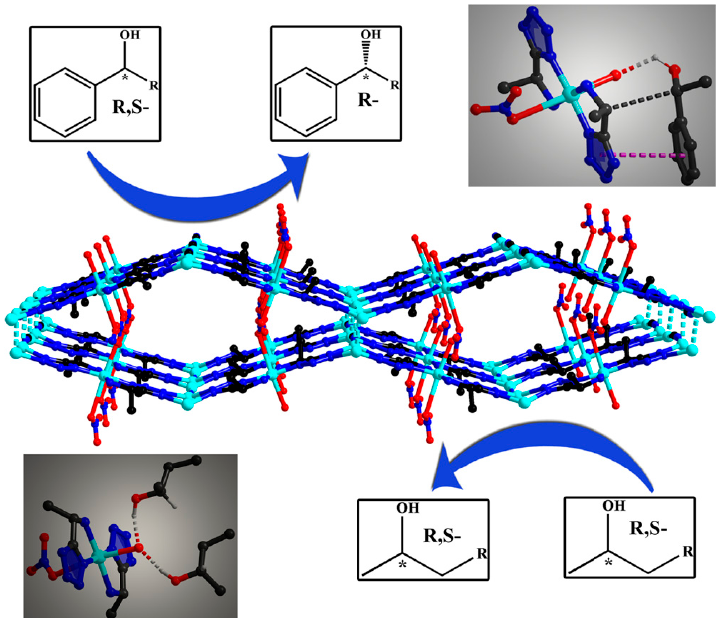
Figure 18. Possible interactions between the chiral framework and chiral alcohols. Reproduced from [119] with permission from the American Chemical Society.